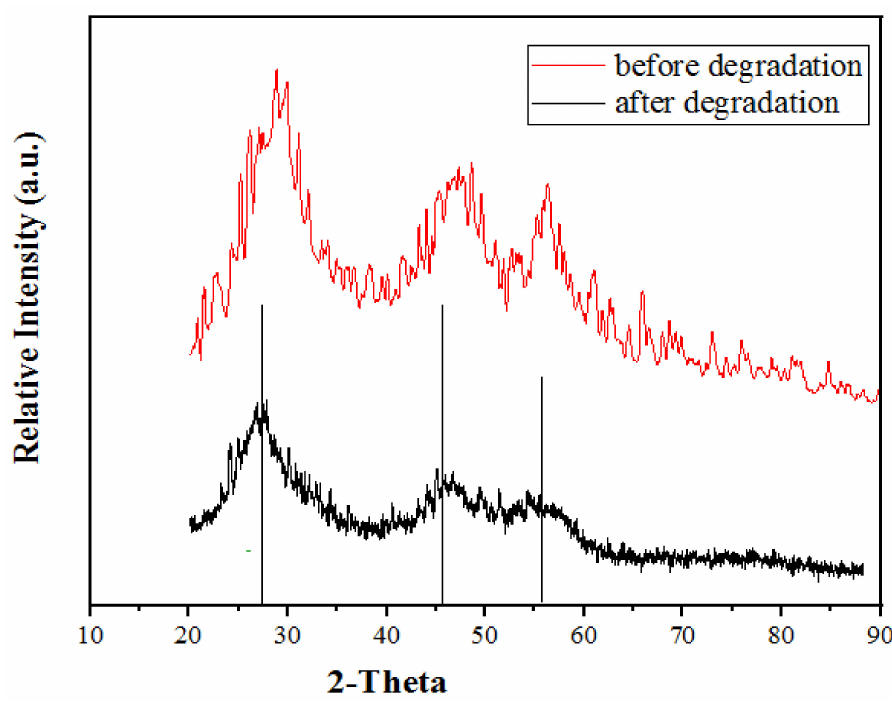
Figure 18. XRD patterns of Mn 2+ :ZnS Qds before and after sonophotocatalytic degradation of SDB. During photocatalysis, the irradiation of ZnS with UV light photons, results in HO